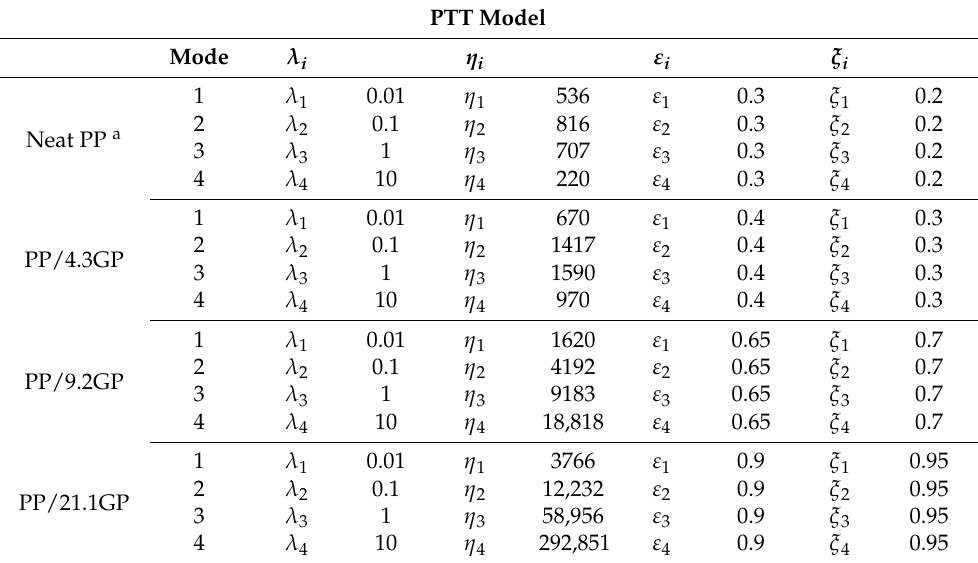
Table 1. Tuned material parameters for neat PP and PP composites with various graphite filler (GP) content; a based on Tang et al.